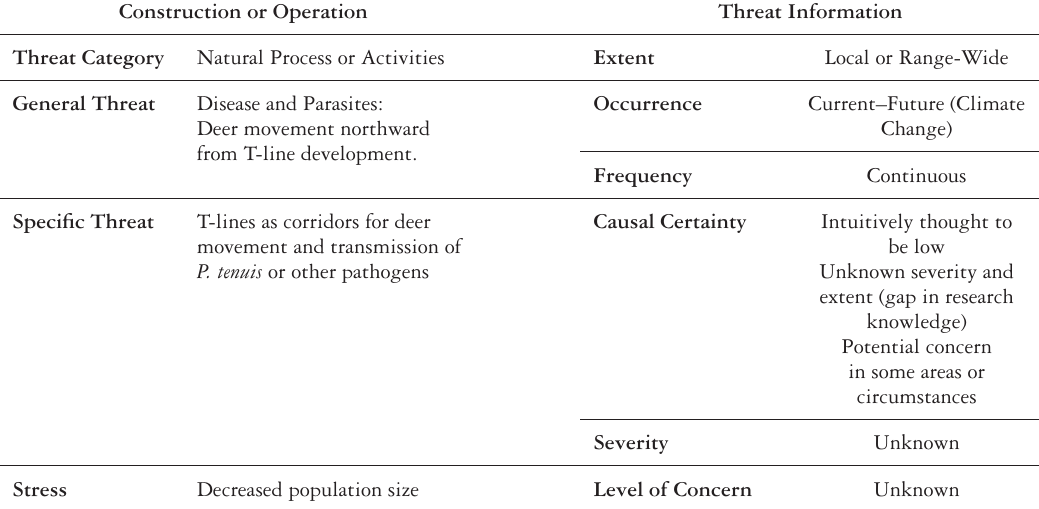
Table 4. Implications of threat categories for Site Selection and Environmental Assessment determined during Manitoba Hydro Boreal Woodland Caribou Workshop addressing expansion of deer range due to increased forb and shrub habitat along transmission line right-of-ways and possible transmission of brainworm to boreal woodland